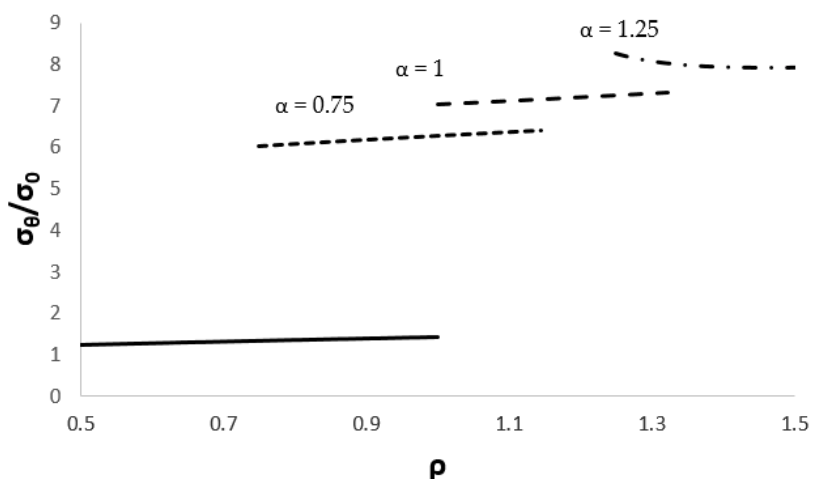
Figure 6. Radial distribution of the circumferential stress at ν = 10 and several values of α .